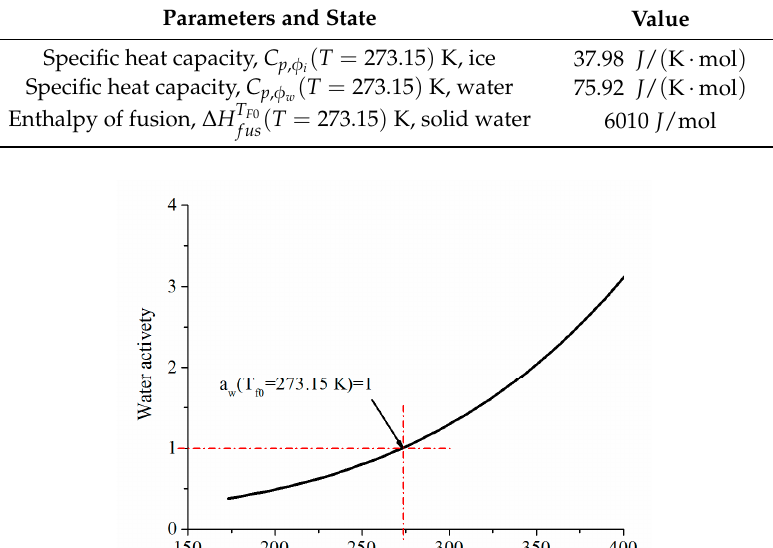
Table 1. Thermodynamic properties of pure water and methanol at 1 atm [18] .